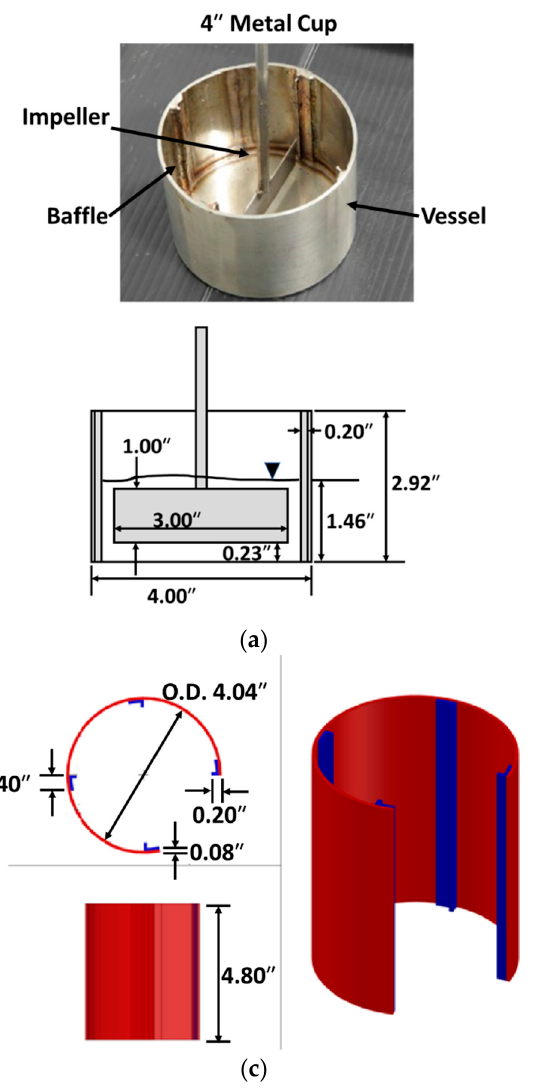
Figure 2. Schematic dimensions of flocculation vessels, baffles, and impellers: ( a ) 4 ″ metal cup setup for flocculation; ( b ) 6 ″ metal cup setup for flocculation; ( c ) dimension of the baffle for a 1000 mL of glass beaker as the flocculation vessel; ( d ) paint-mixing impeller for the FFT homogenization.